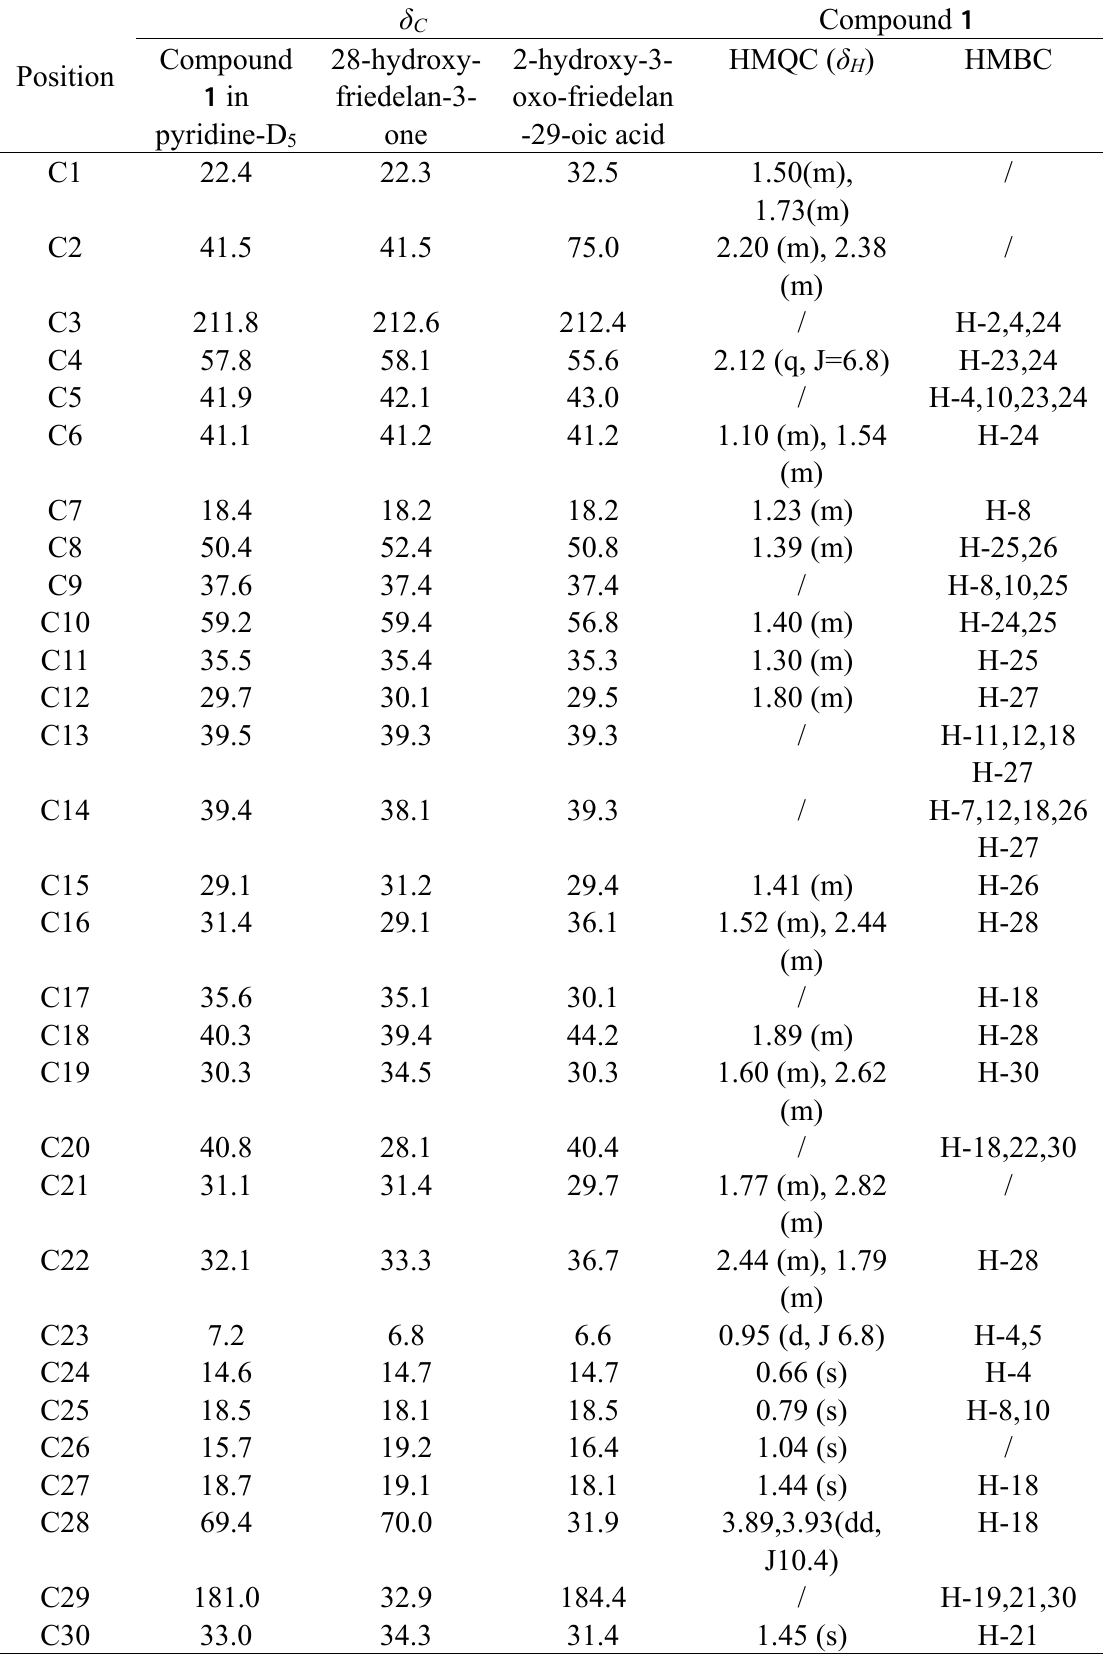
Table 1. 1D NMR and 2D NMR data for compound